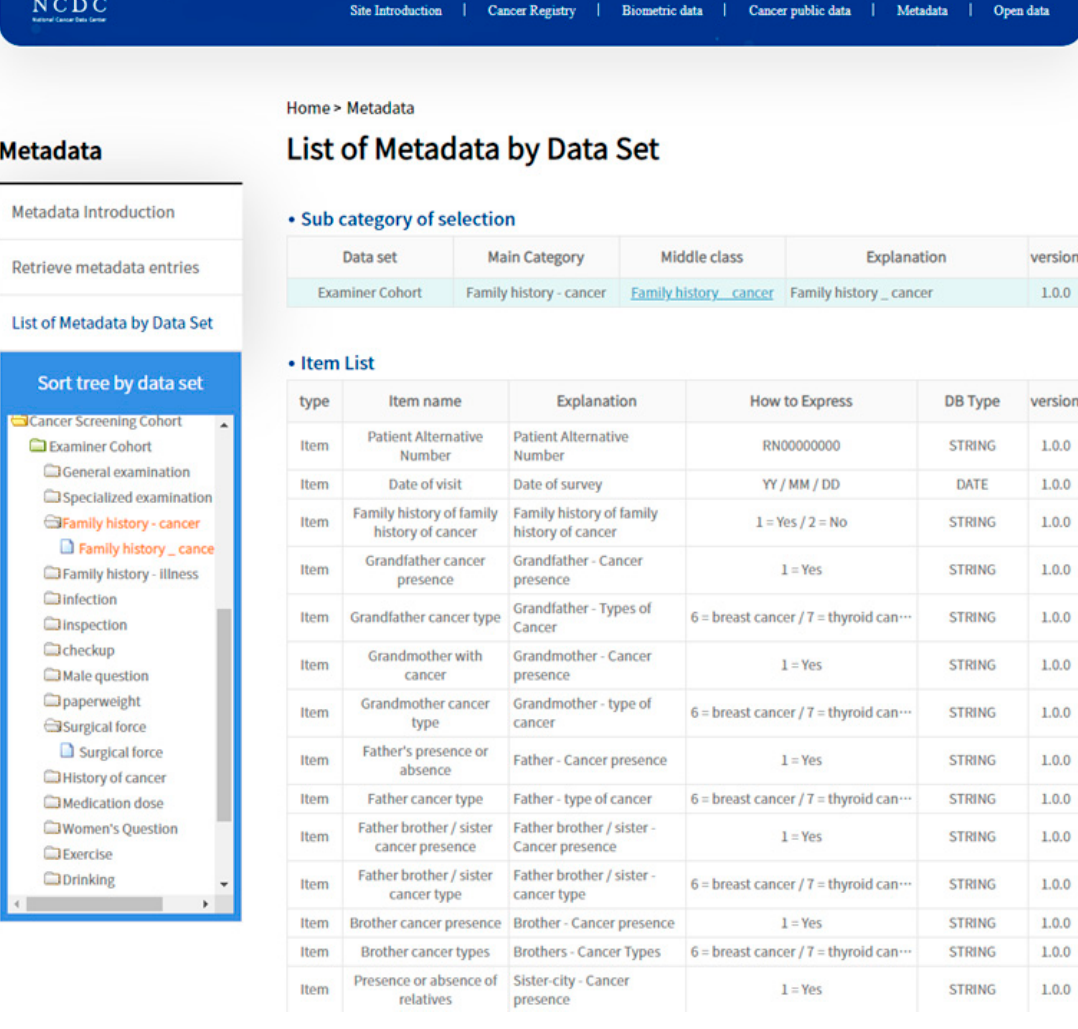
Figure 6. A screenshot of the National Cancer Data Center (NCDC) webpage displaying a list of items and a description for ovarian cancer (https://www.cancerdata.kr/dataSetMetaLst.do).